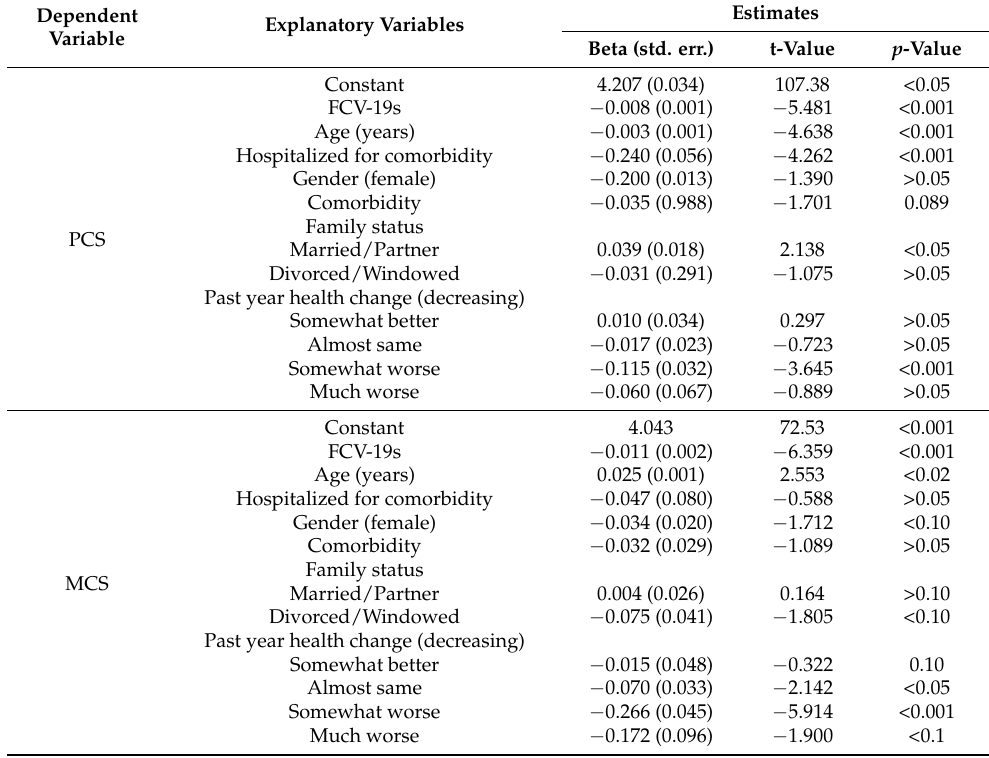
Figure 2. Distribution of FCV-19s responses by past Coronavirus infection (Yes/No). The results of the multivariate analysis with Gamma regression, which was used to model the PCS and MCS scores, are presented in Table 5. Higher fear of COVID- 19, increasing age, having at least one comorbidity and previously hospitalized for this comorbid condition, female gender, being divorced or widowed and past year self-reported decreasing health were negatively associated with physical health. Fear of COVID-19 and age were the two strongest predictors of physical health. The results were quite similar in the MCS model, with the most noteworthy difference being the positive association between age and mental health. Table 5. PCS and MCS models with Gamma